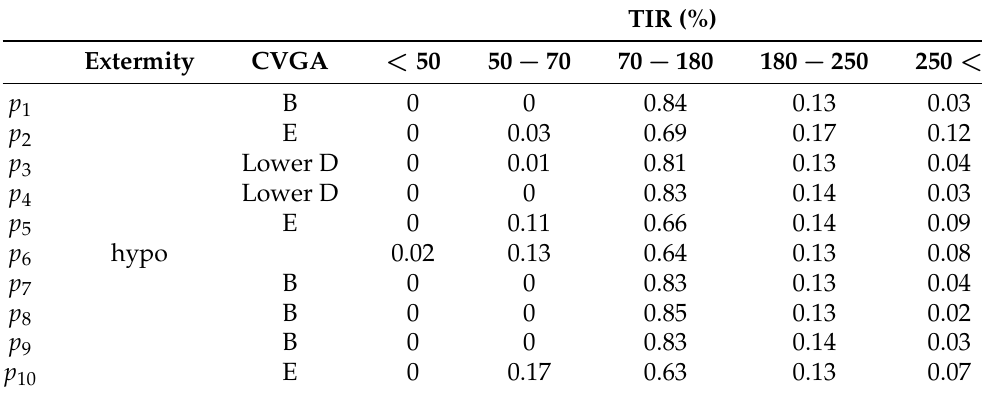
Table 4. CVGA and TIR metrics, corresponding to the fast